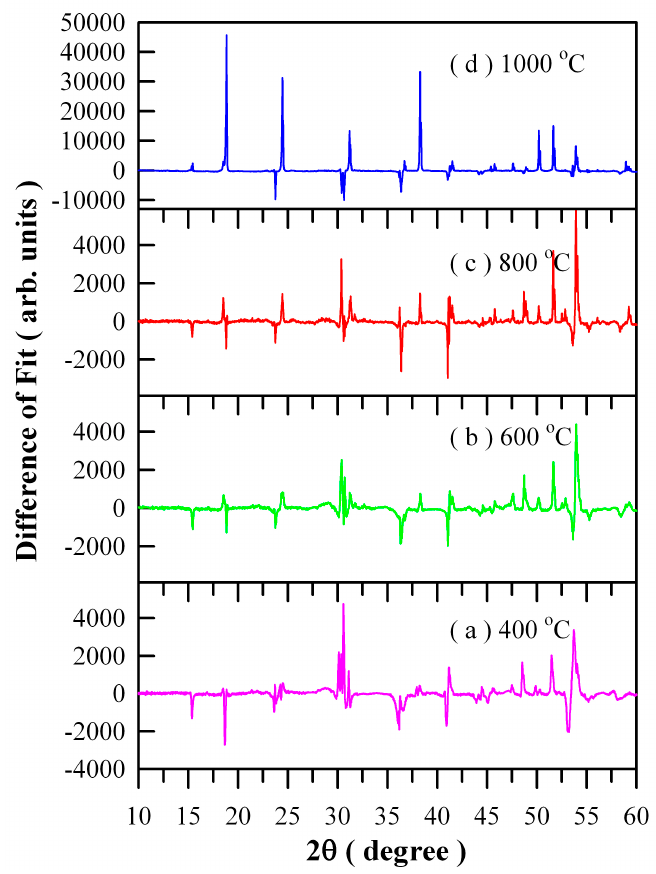
Figure 4. Differences between experimental and calculated XRD data of Eu-doped ZnWO 4 precursors subjected to annealing at different temperatures: ( a ) 400 °C; ( b ) 600 °C; ( c ) 800 °C; and ( d ) 1000 °C.